Question: In one sentence, what is this figure communicating?
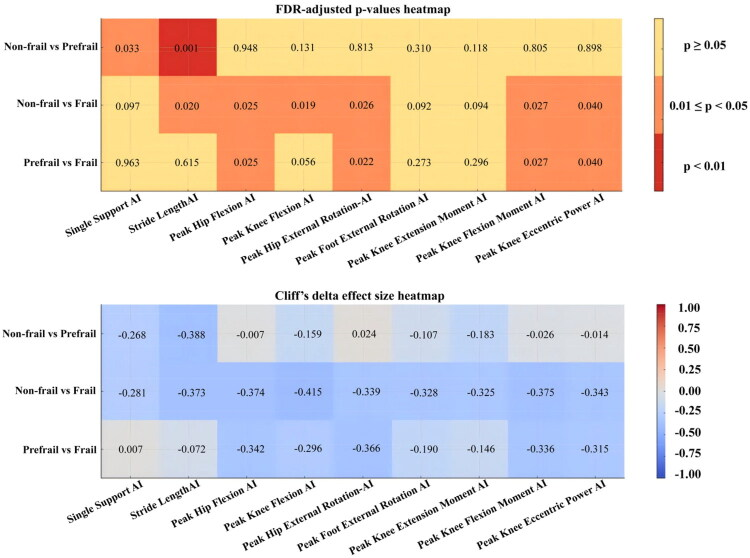
Answer: Vertical dual heatmap summarizing between-group differences in gait asymmetry indices. Note: The upper panel displays Benjamini–Hochberg FDR-adjusted p-values for the three pairwise comparisons (non-frail vs prefrail, non-frail vs frail, prefrail vs frail) using discrete threshold coloring. The lower panel shows the corresponding Cliff’s delta effect sizes on a continuous scale from −1 to +1, where positive values indicate greater asymmetry in the first group of each comparison and negative values indicate greater asymmetry in the second group; larger absolute values reflect larger between-group differences; AI: Asymmetry Index.